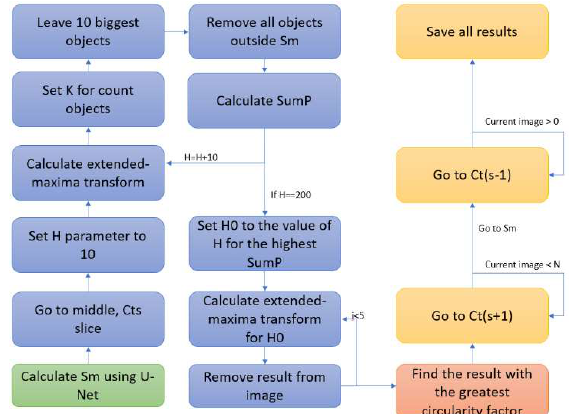
Figure 6. Full diagram showing the steps of kidney boundary detection in the CT image. The starting point of the system is marked in green. The main steps of the kidney localization procedure using extended-maxima transform are marked in blue. The result of the kidney boundary of 𝐶𝑡 𝑠 is marked in red. The steps in the slice scanning procedure are marked with orange.